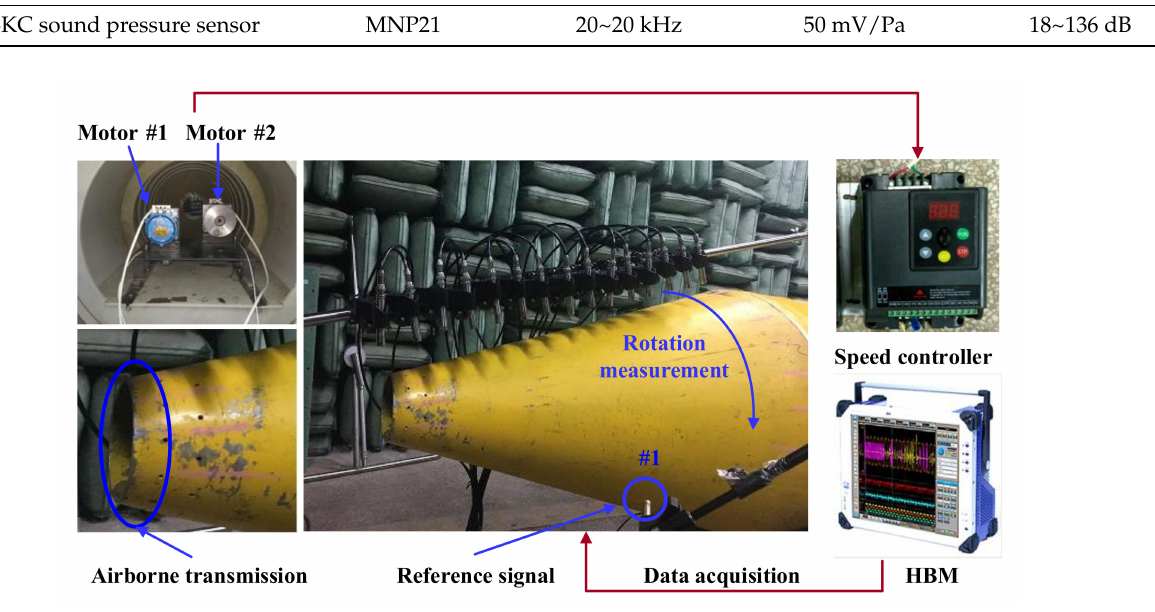
Figure 23. Measurement